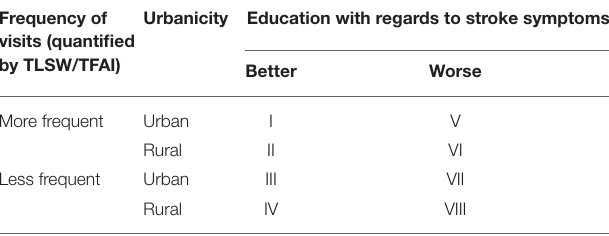
TABLE 7 | Definition of socio-geographic scenarios